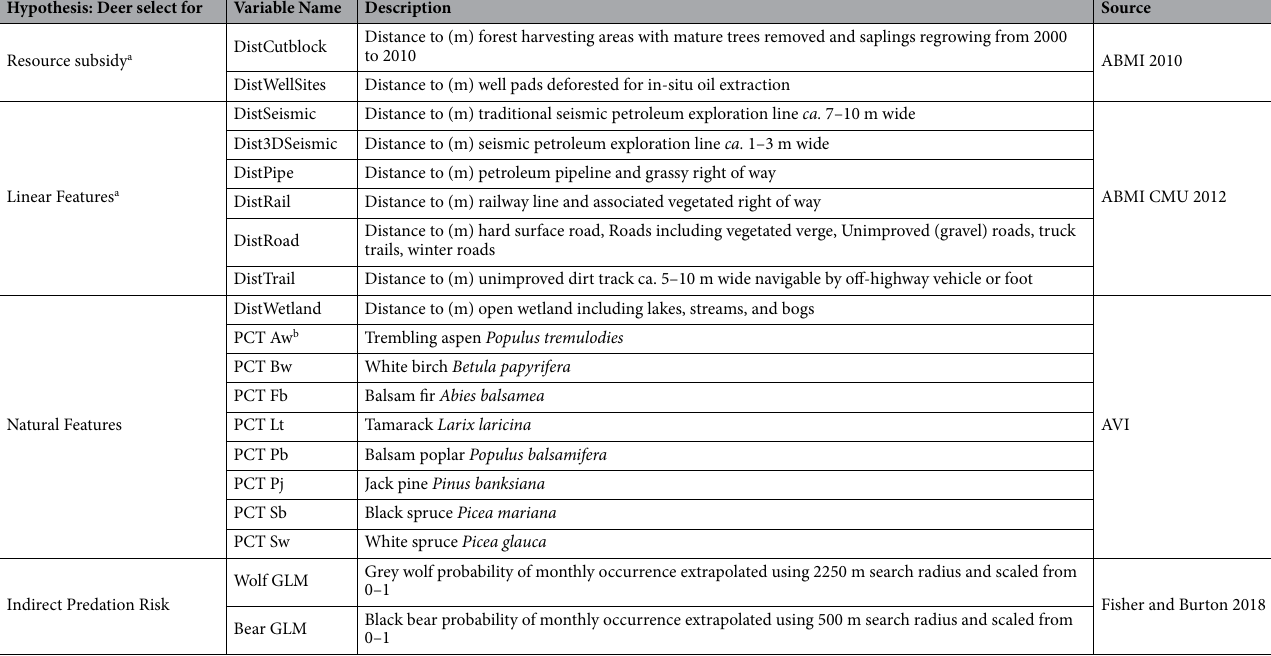
(Table 1) were extracted for each used and available location using the raster package 52 in R 4.1.1 53 . To check that the available sample represented the available landscape, we identified deer with the smallest and largest number of used locations for each season. Next, we created ten bootstrapped available datasets, each consisting of two times the number of used locations randomly sampled from within the respective deer’s seasonal MCPs, extracted covariates, and visually compared the distribution of variables across bootstrapped available samples. Variable distributions sufficiently overlapped across the bootstrapped samples (Figure S2–S4), irrespective of deer sample size (our sampling unit). We generated six RSF models (Table 2) for each of four biological seasons to examine the drivers of popu- lation-scale deer resource selection. We used logistic regression in a Generalized Linear Mixed-Effects Model (GLMM) 54 . As we had a number of deer that contained data across multiple years, we included “individual-year” as a random effect on the intercept to avoid potential pseudo-replication arising from the dependent nature of telemetry data sampled from individuals and years 55 . We log-transformed distance variables and standard- ized percent cover and predator occurrence covariates (mean = 0, s.d. = 1) and tested for multicollinearity 54 . We excluded collinear variables with r > 0.7 and a variance inflation factor (VIF) > 3 56 . Models within each season were ranked using an information-theoretic approach based on Akaike Informa- tion Criteria corrected for small sample size (AICc) scores where the lowest AICc score reflects the most parsi- monious model with the most deviance explained 57,58 . We used k-fold cross validation, whereby each individual’s data within corresponding seasons were split into k = 10 folds to validate each candidate model 51 and each subset was evaluated using models trained with k – 9 alternative subsets. Ethics and permits. All animals were captured and processed under approved handling protocols by Inno- Tech Alberta’s Animal Care Committee and permitted by Alberta Environment and Parks (Permit #s 49365 and 48602). All methods are reported in accordance with ARRIVE guidelines.